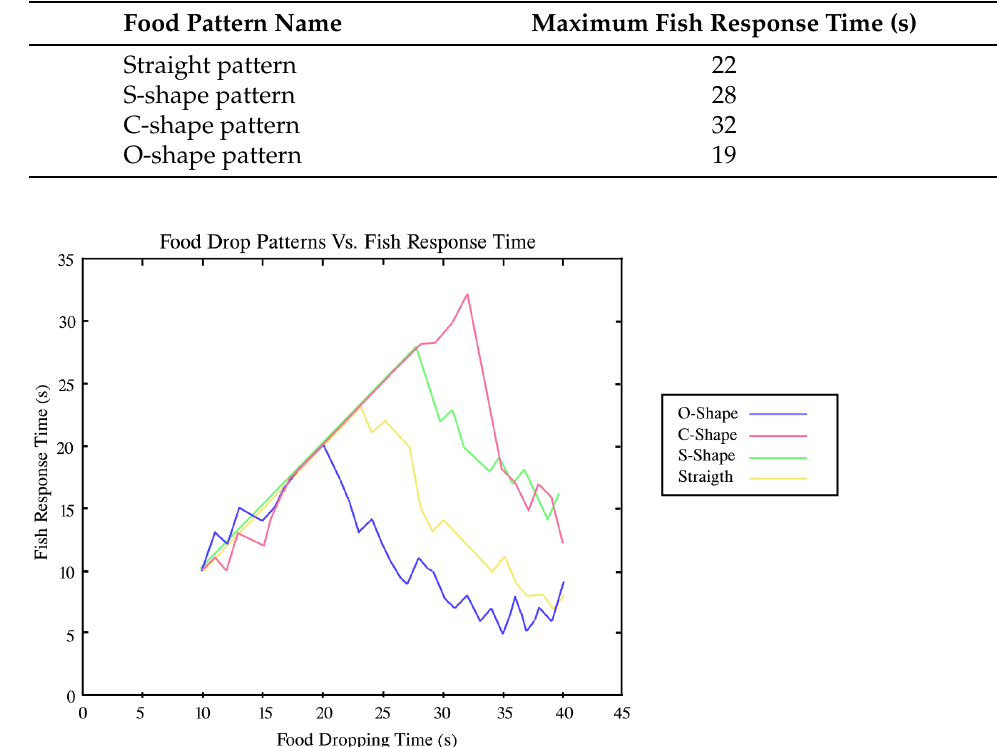
Table 6. Maximum fish response time for each fish food pattern.